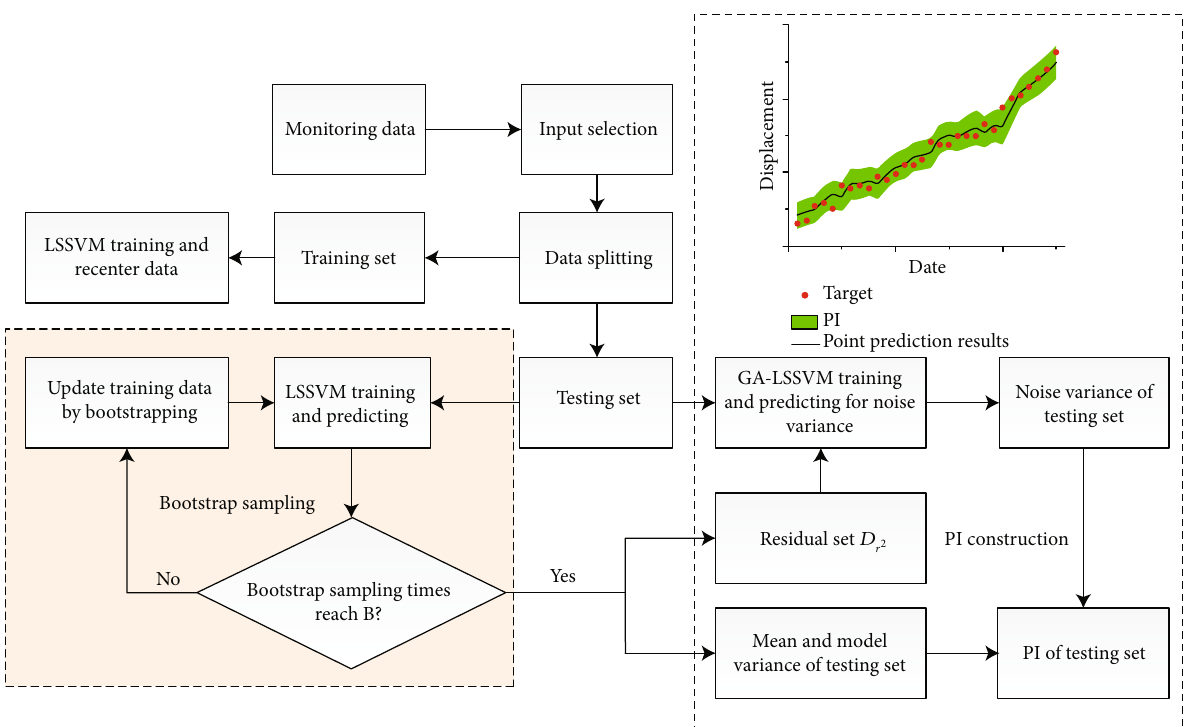
Figure 1: Generalized framework of the point and prediction interval estimations based on the B-LSSVM